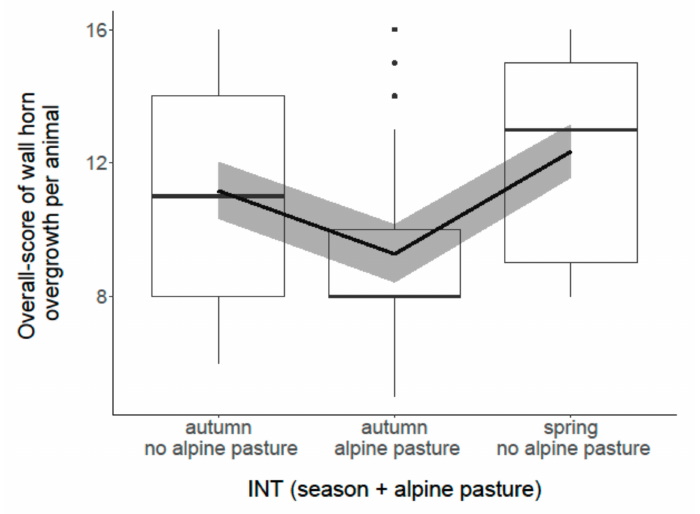
Figure 3. Association between “overall score of wall horn overgrowth per animal” and the factor “INT (season + alpine pasture)”. Box plot shows medians and interquartiles.. The dots represent outlier data points. The black line represents the model estimate, the gray colored area the 95% confidence interval.